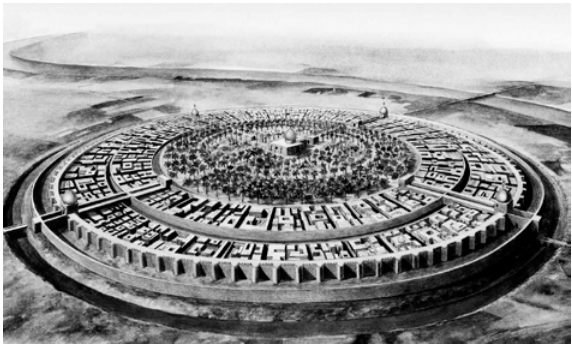
fig. 2. Plan of the round city of Baghdad in the 10th century, the peak of the abbasid Caliphate Source: (Soutif